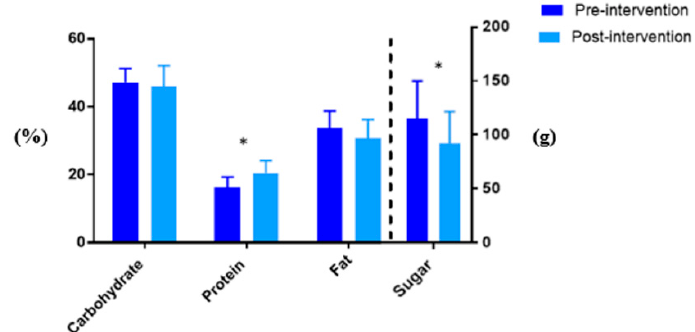
Figure 1. The % Energy intake from carbohydrate, protein, and fat as well as absolute sugar intake (g) pre- and post-intervention. * p < 0.05 for pre- versus post-intervention values.